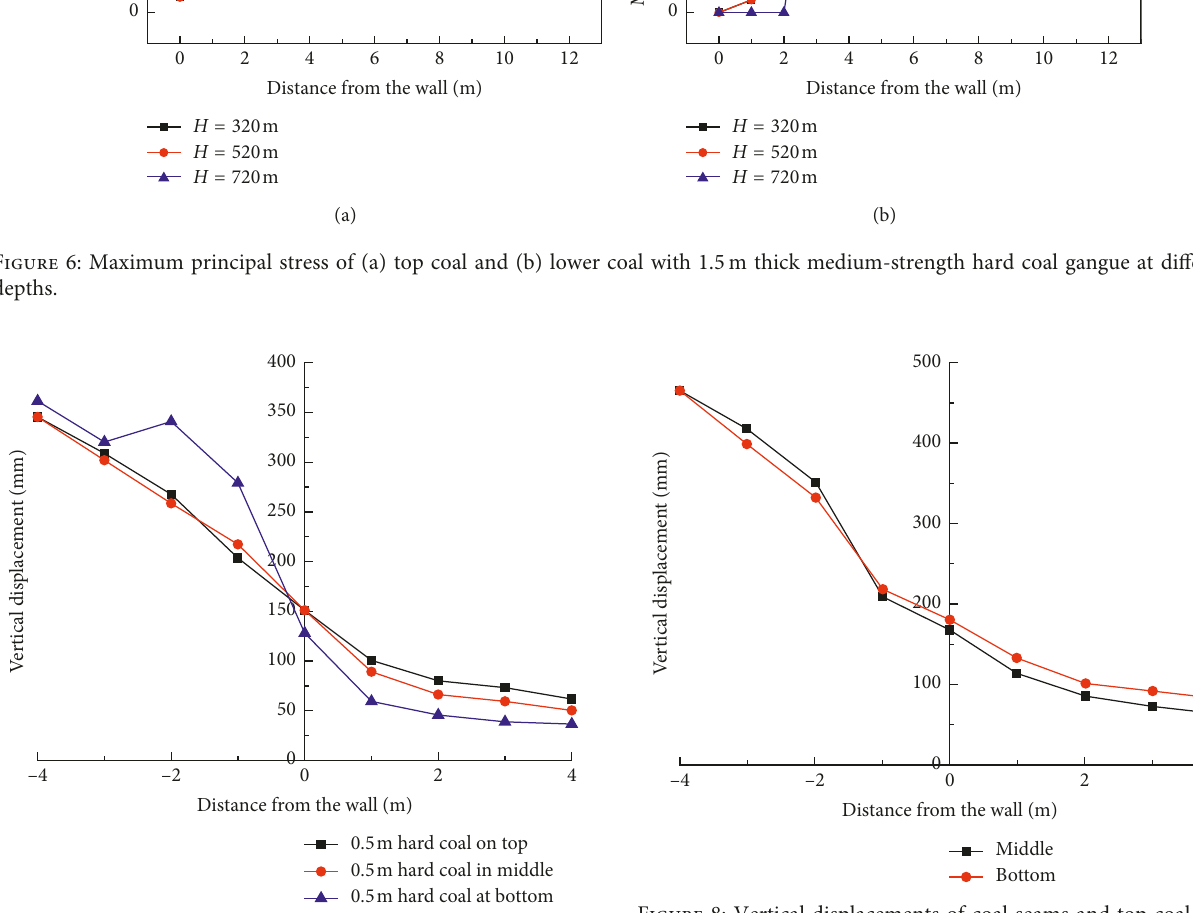
Figure 8: Vertical displacements of coal seams and top coal with 0.5 m high-strength upper hard